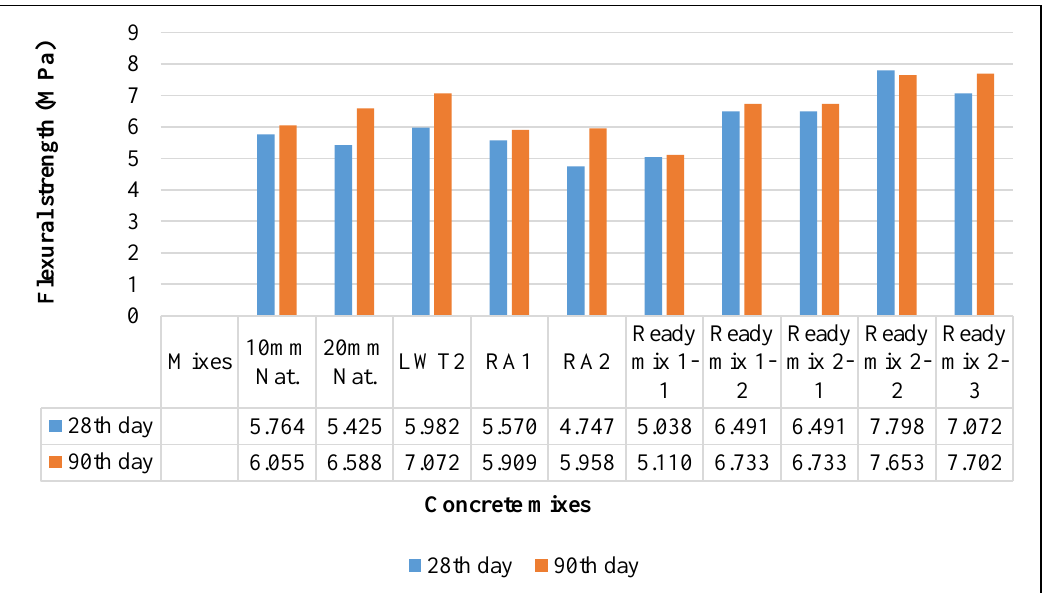
Figure 8. Flexure strength for different concrete mixes at 28- and 90-day.